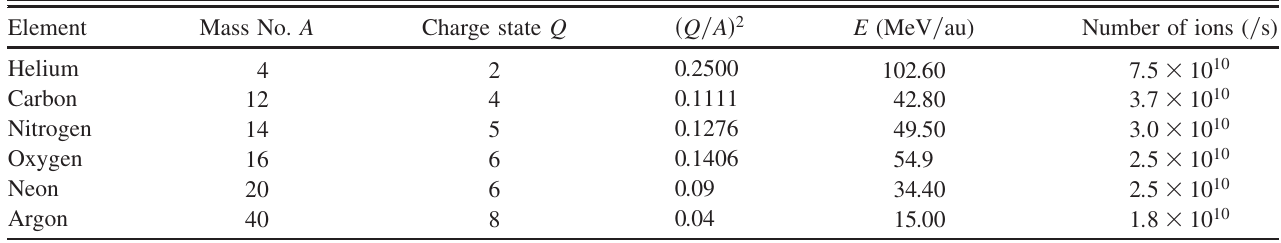
TABLE VII. Ion beam parameters at the first stage of the KEK-DA ( B r ¼ 0 : 84 ð Tesla Þ (cid:4) 3 : 3 ð m Þ ). Element Mass No. A